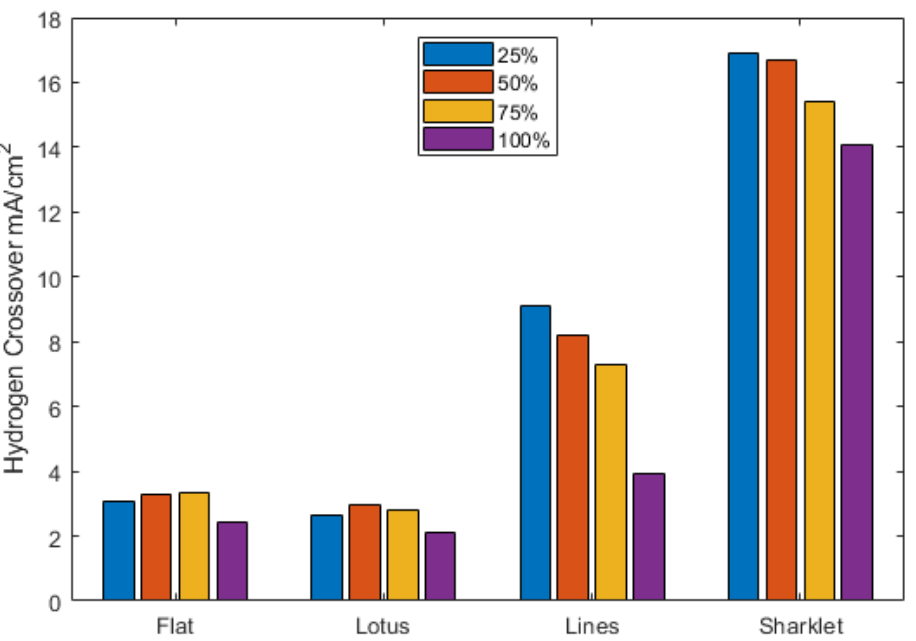
Figure 6. Hydrogen crossover for each pattern at different humidity levels.